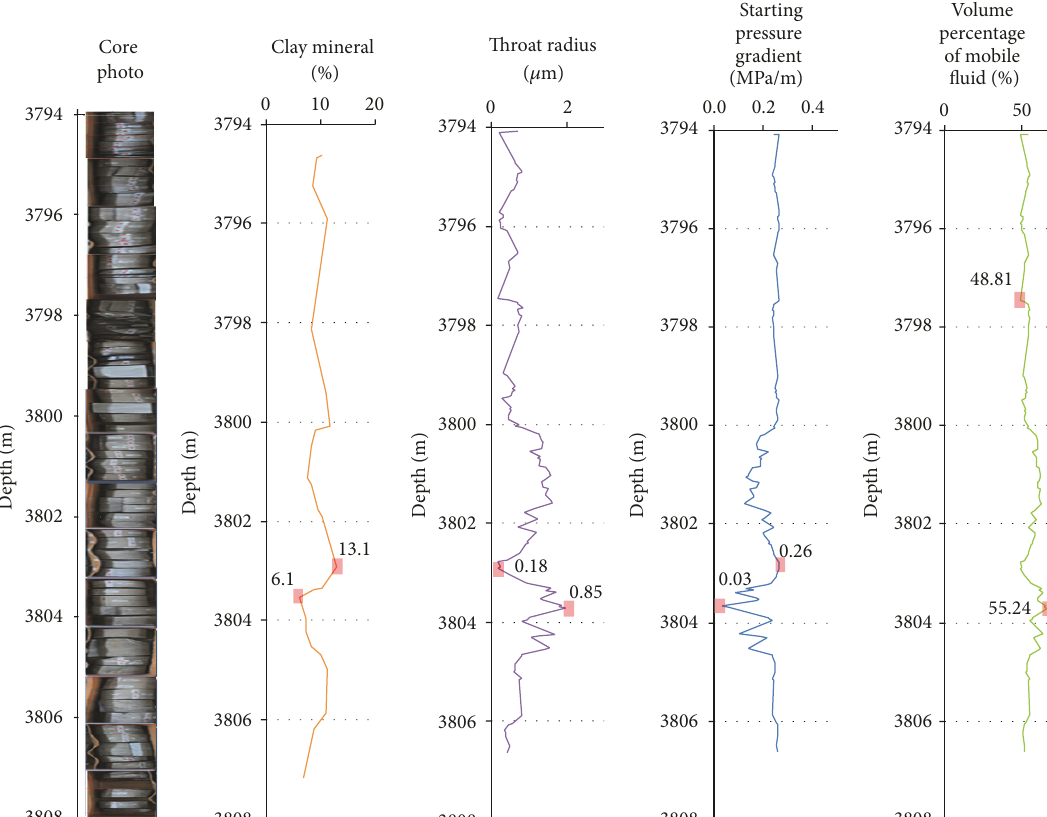
Figure 3: Curves of various petrophysical parameters changing with